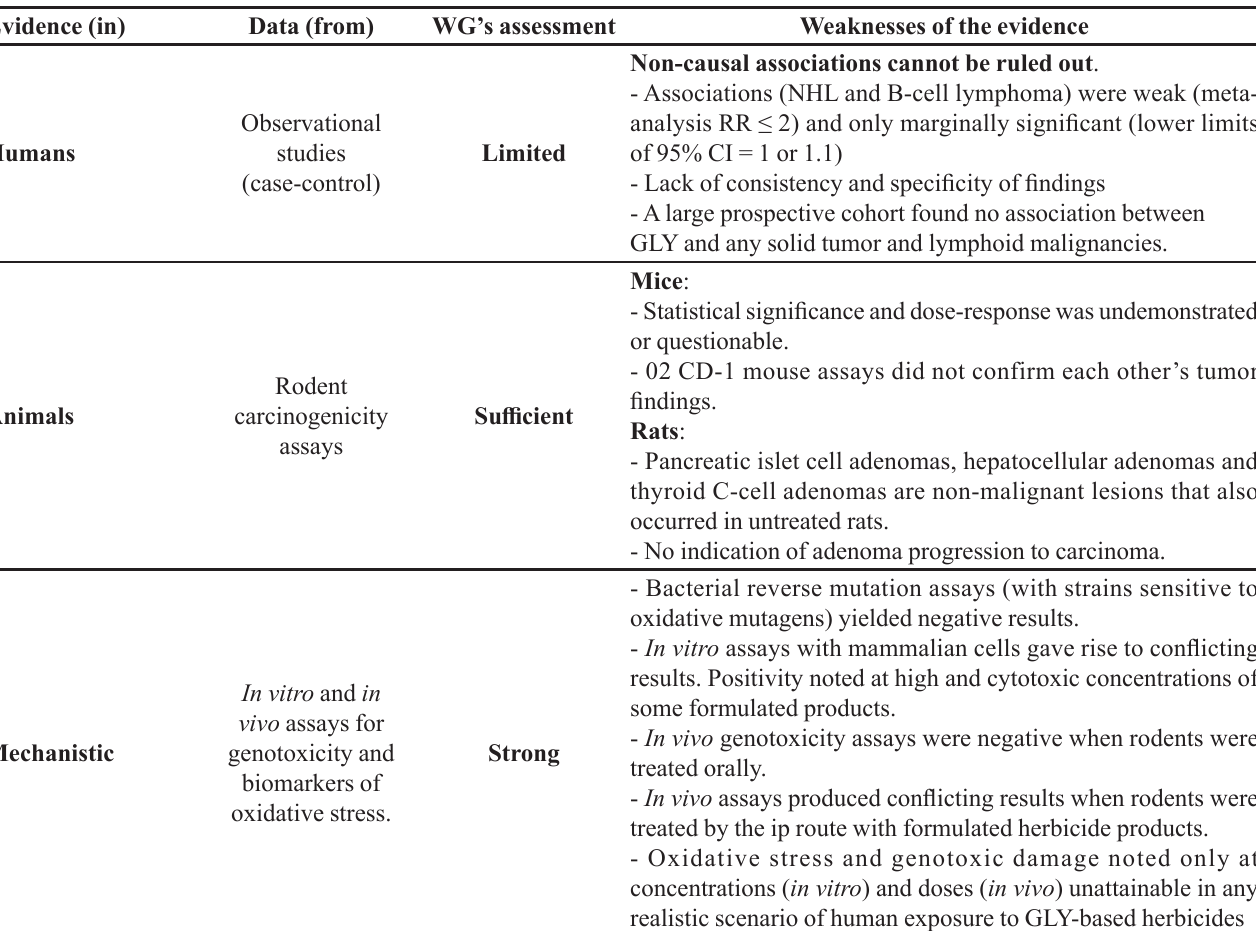
TABLE I - Weaknesses of the evidence considered by the IARC working group to place glyphosate into category 2A (“probably carcinogenic to